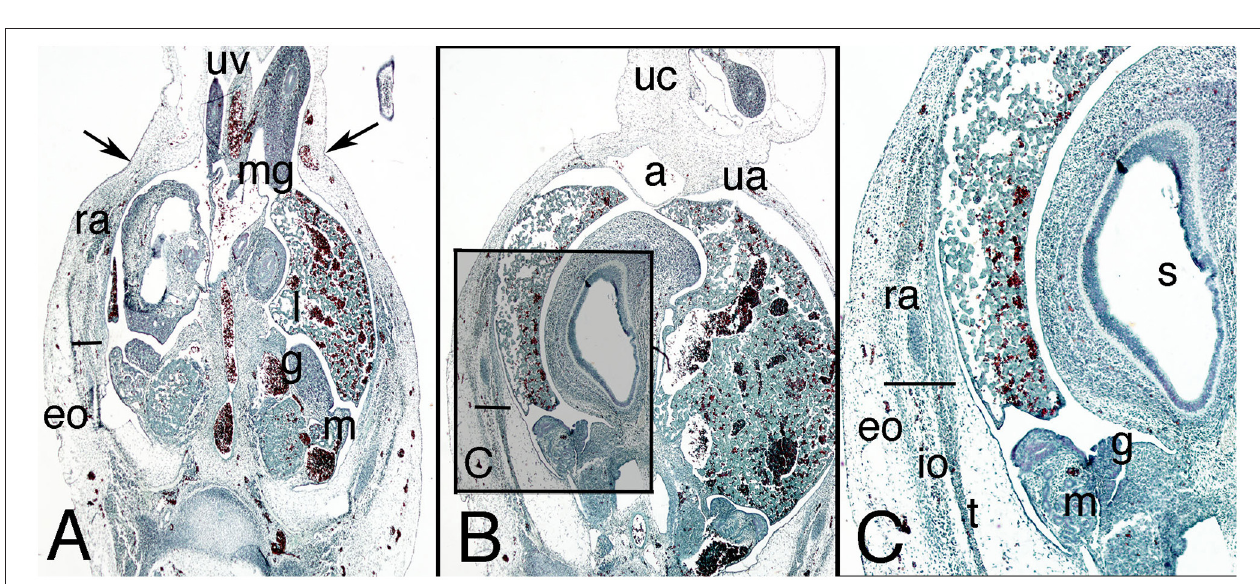
FIGURE 1 | Cross section of the embryo DD-10 (stage 16). Hematoxylin and eosin staining. It represents the presumptive period of the abdominal wall. (A) (4X), level of the physiological hernia; the inbox (C) delineates the outgrowth region of the myoblast in the dorsolateral abdominal wall. (B) (4X), the abdominal wall just below the level of the physiological umbilical hernia with the two umbilical arteries. aw, abdominal wall; mesonephric ridge (m) behind the mesonephric duct (W); cc, celomatic cavity; g, gut; gc, gonad crest; n, nerve; uh, physiological hernia; uv, umbilical arteries; vv, vitelline vessels.